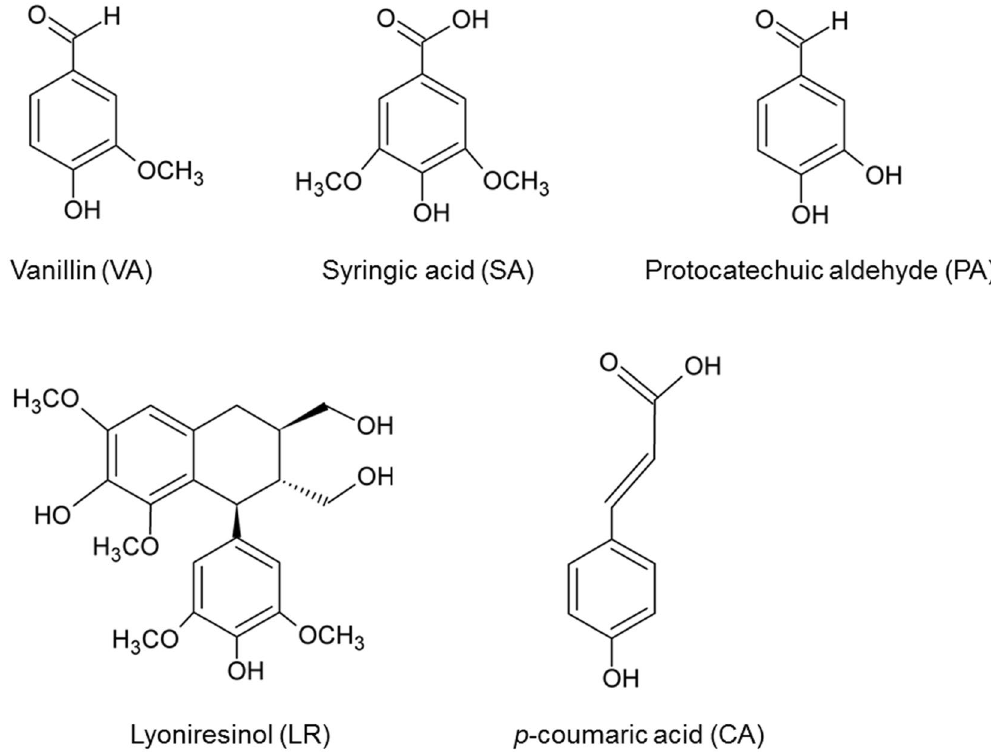
Figure 2. Determination of the chemical structures of active compounds isolated from ume seed. Active compounds were isolated from ume seed extract based on their inhibitory effect on antigen-induced β -hexosaminidase release. Isolated compounds were identified as vanillin (VA), syringic acid (SA), protocatechuic aldehyde (PA), lyoniresinol (LR) and p -coumaric acid